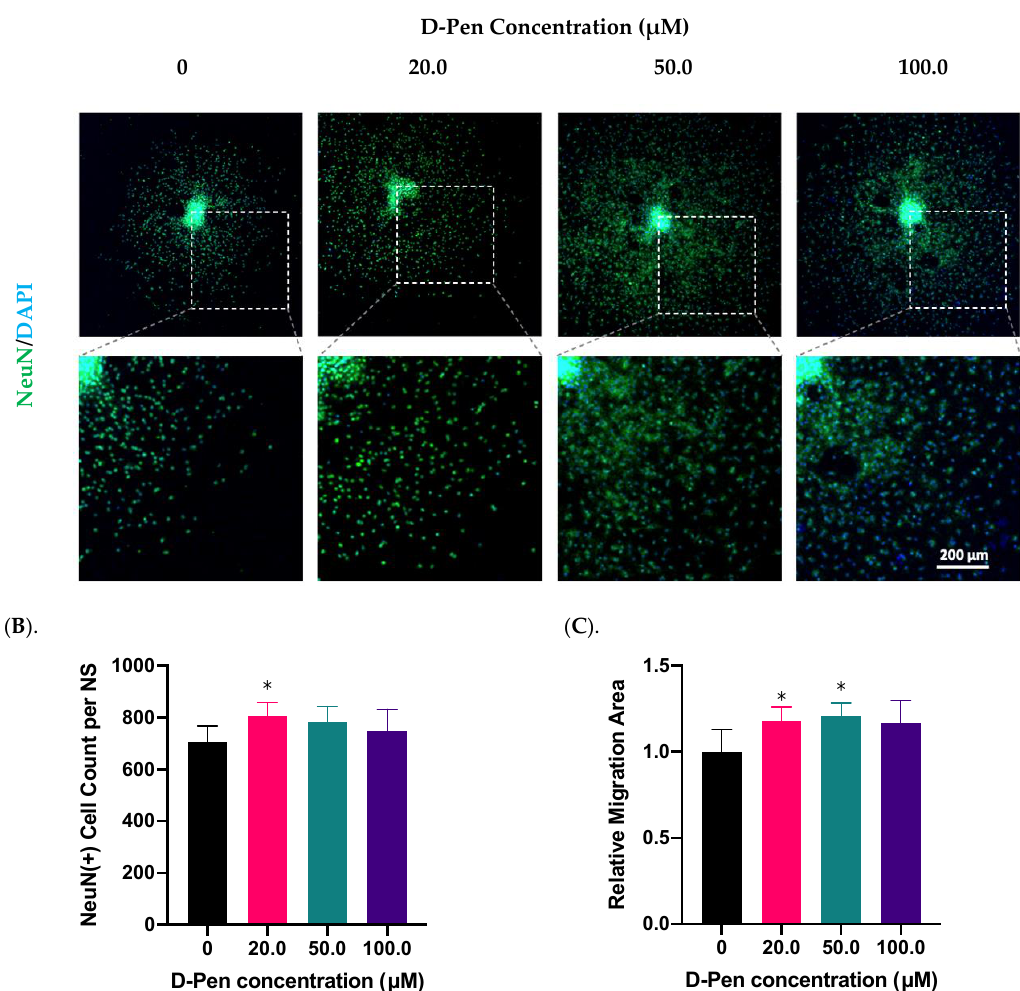
Figure 3. Treatment with D-Pen alone enhanced neurosphere growth in vitro. ( A ). D-Pen treatment exhibited dose-specific increases in neurosphere differentiation and migration. Neurospheres were stained with NeuN. Scale bar = 200 μm. ( B ). NeuN(+) mature neurons per neurosphere were quantified in each D-Pen treatment group. Data represent mean ± SD, n = 6; * p < 0.05 as compared with controls. ( C ). Migration areas of neurospheres were quantified and normalized to the controls. Data represent mean ± SD, n = 6; * p < 0.05 as compared with controls.